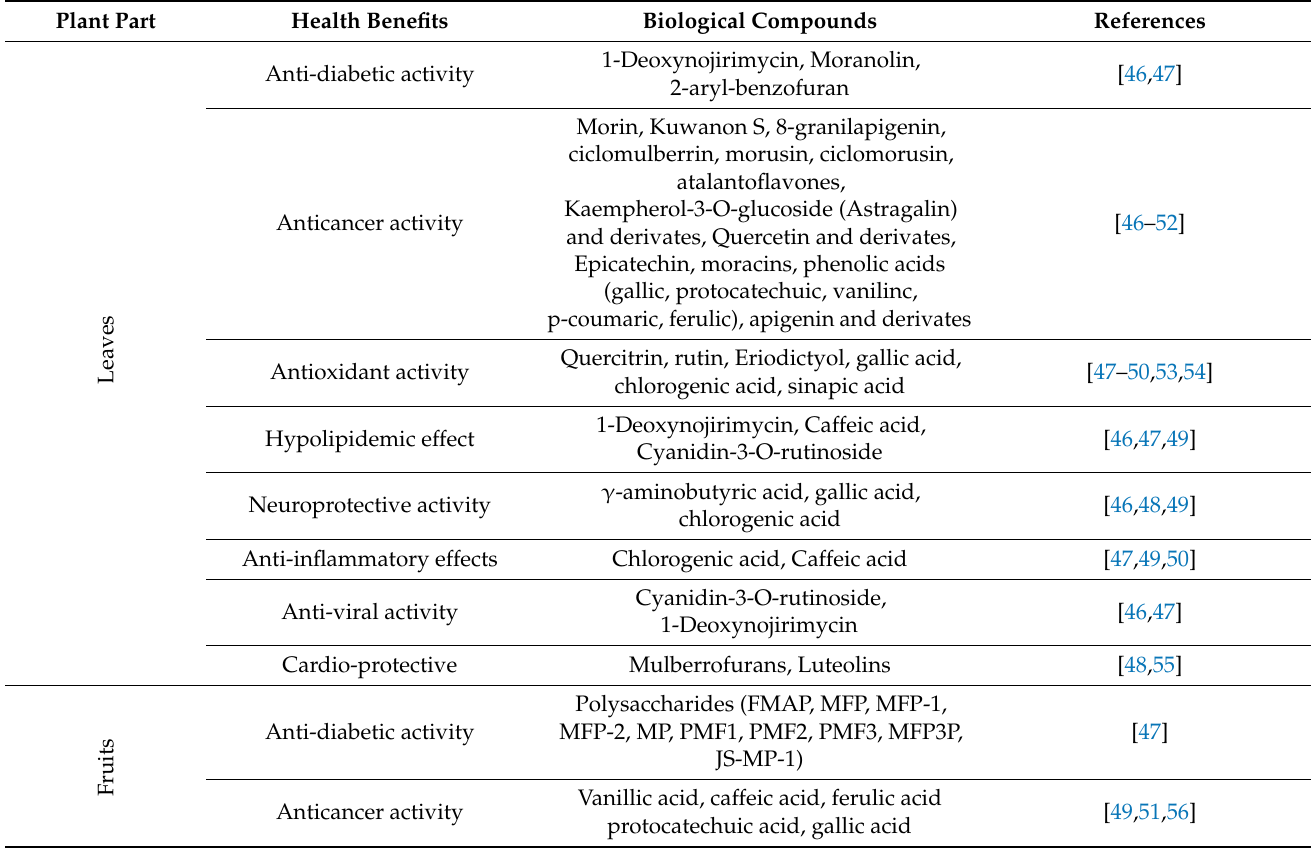
Table 1. Main biological compounds from different parts of mulberry and their health benefits. Plant